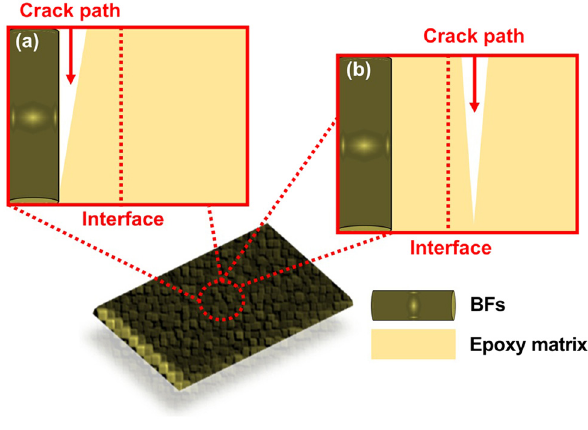
Figure 6: Schematic description of interfacial mechanism: ( a ) BFs/ epoxy composite and, ( b ) OBFs/epoxy